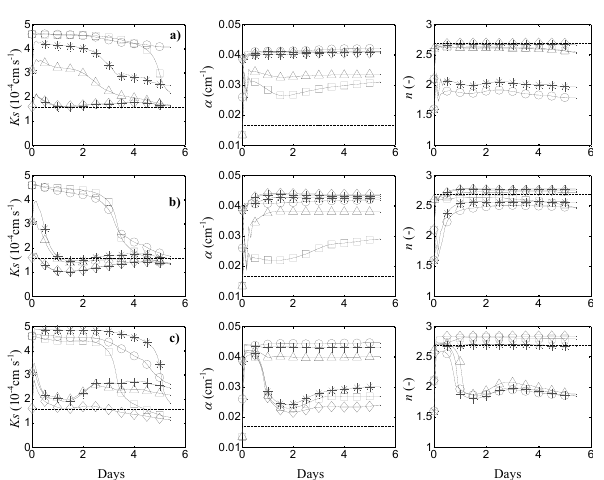
Figure 3. Retrieved VGM parameters K s , α and n for GB1 soil sample with assimilation frequency AF = 1/2h − 1 , and observation depth (a) OD = 1cm, (b) OD = 2cm and (c) OD = 12cm. Compar- isons account for the six pondered sets of initial parameters S1( (cid:13) ) , S2( (cid:3) ), S3( ∗ ) , S4( 1) , S5( + ) and S6( ♦ ) . The dotted line indicates the value of the parameter found by Romano and Santini (1999).